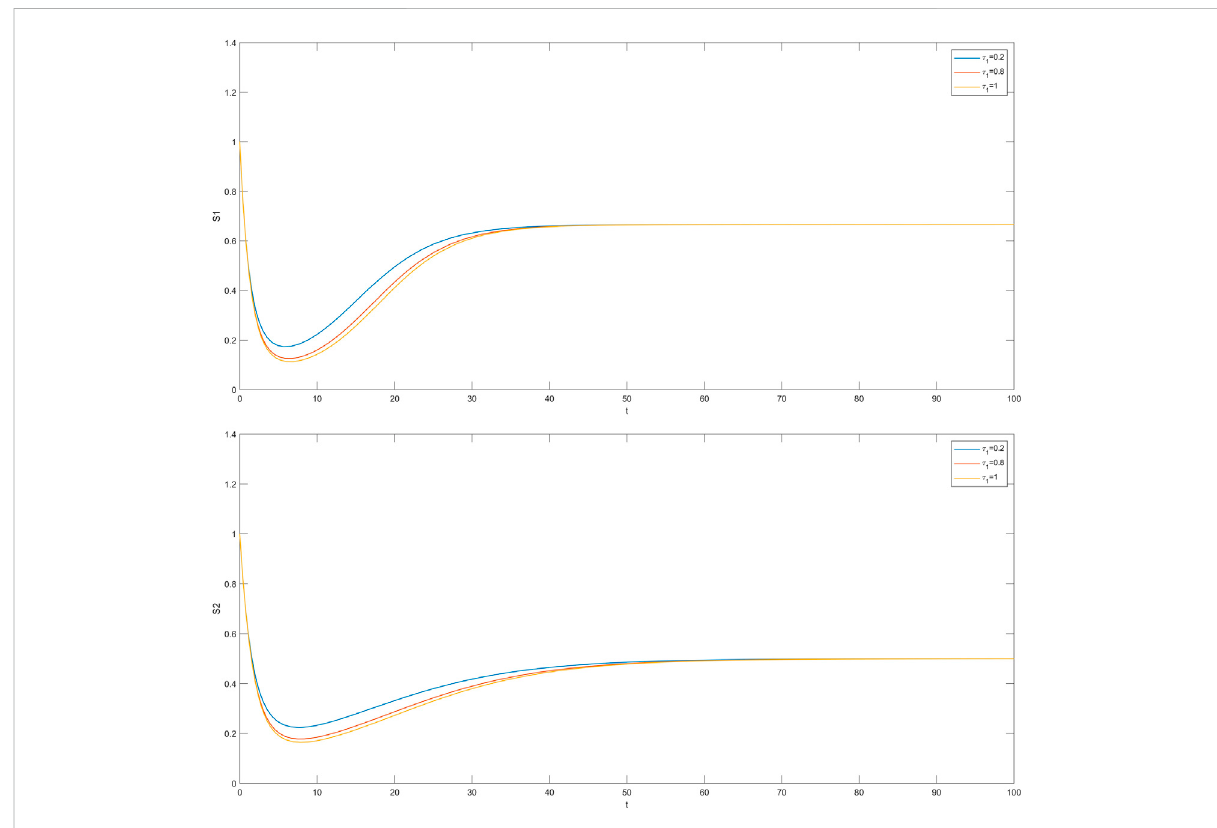
FIGURE 3 Trends of S 1 and S 2 with different time delays when R 0 <